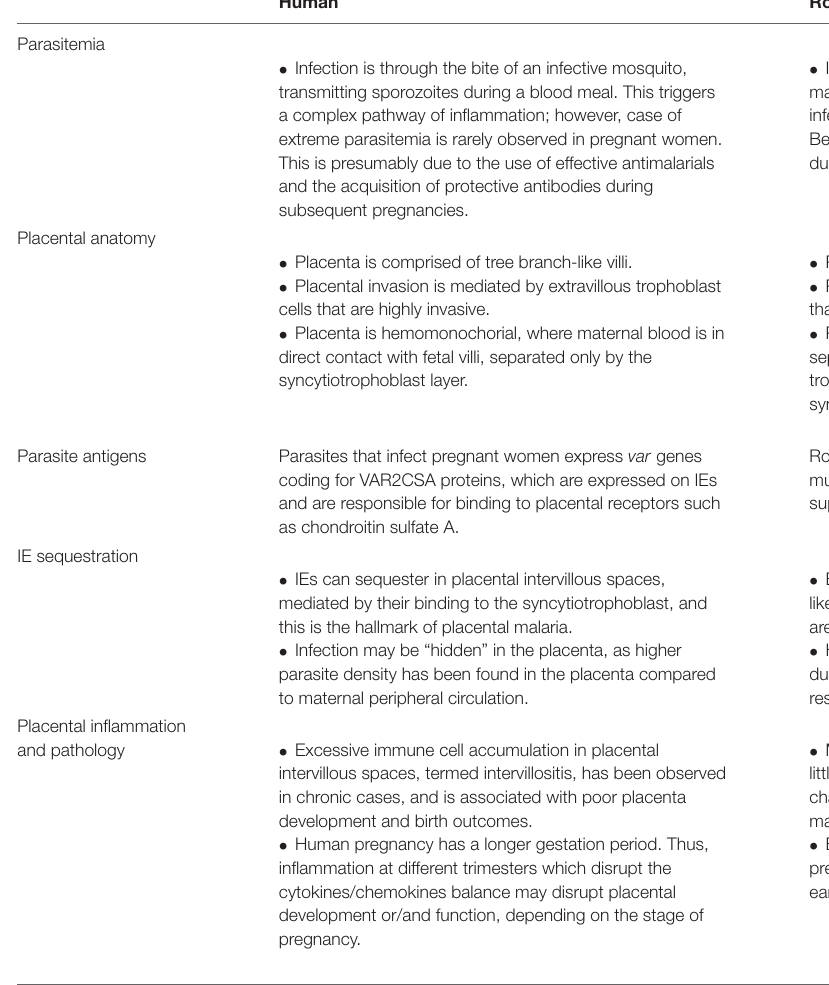
TABLE 1 | Comparison between humans and rodent models of malaria in pregnancy. Human